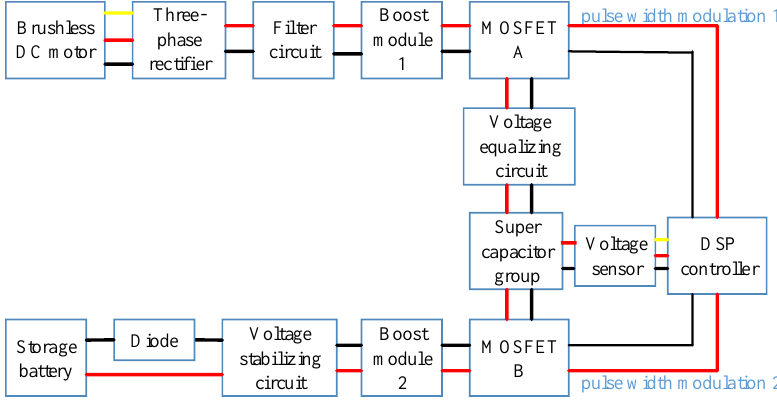
Figure 2. Illustrative diagram of the complex energy recovery device.